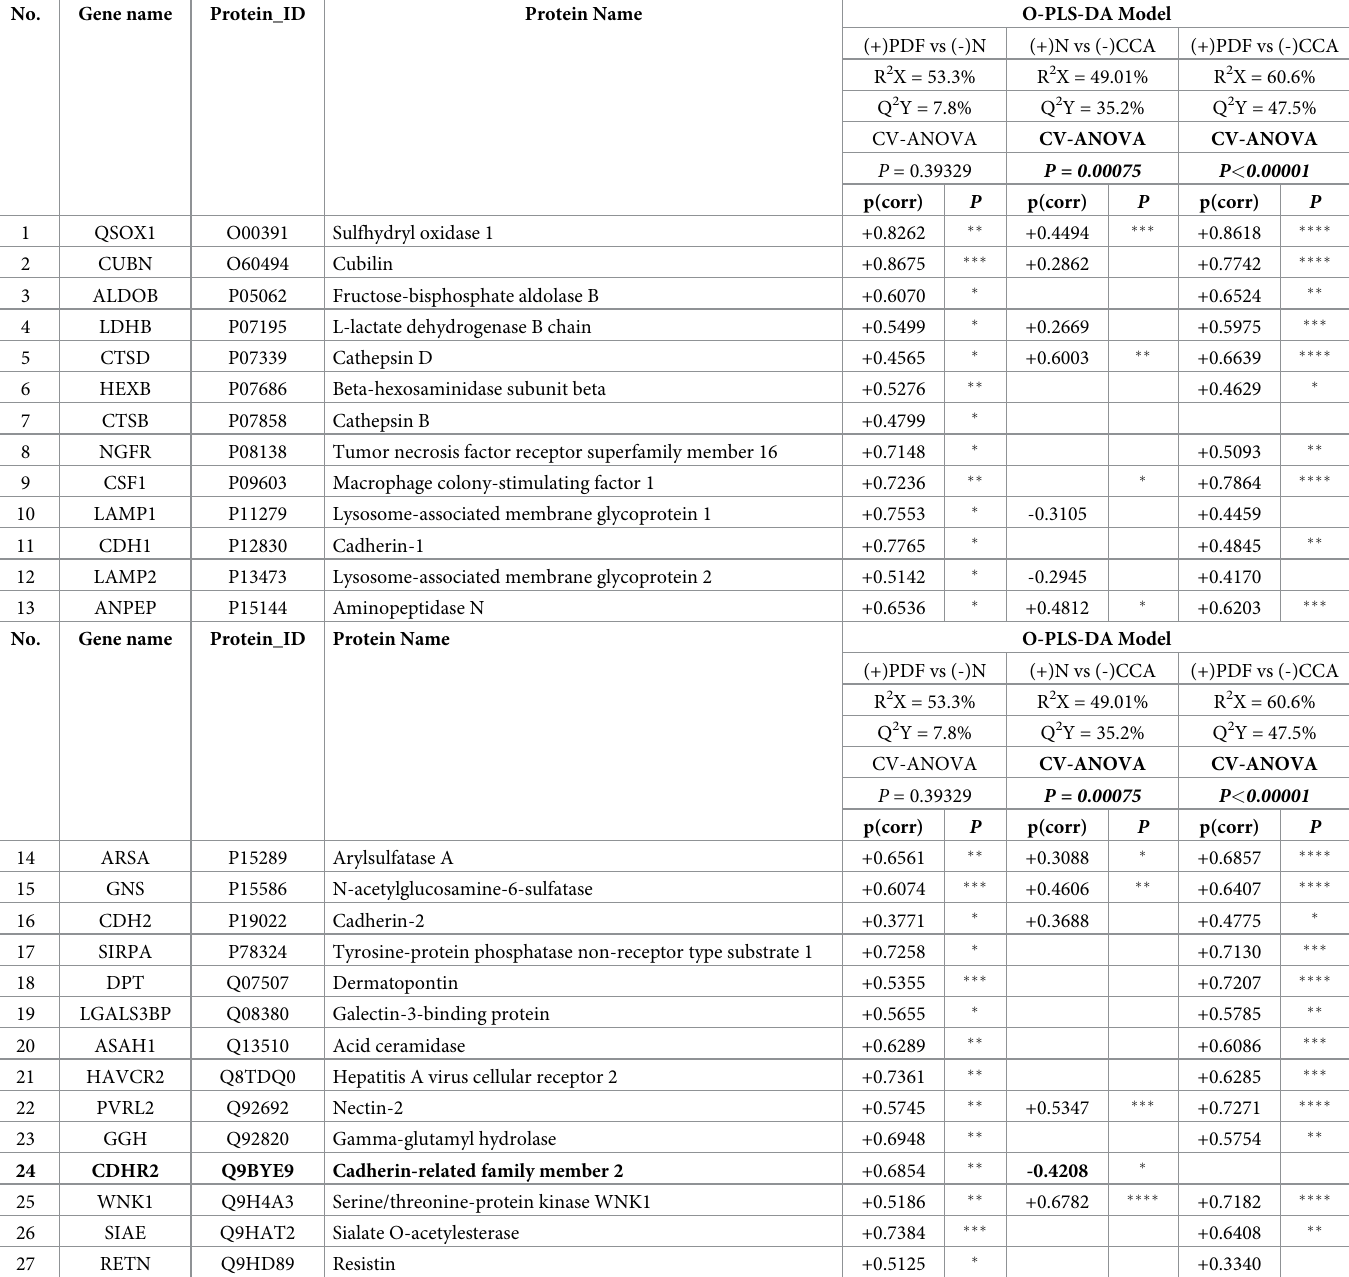
Table 2. The correlation coefficient values of multivariate analysis and the differences of univariate analysis of all qualified urine protein candidates using O-PLS-DA analysis.